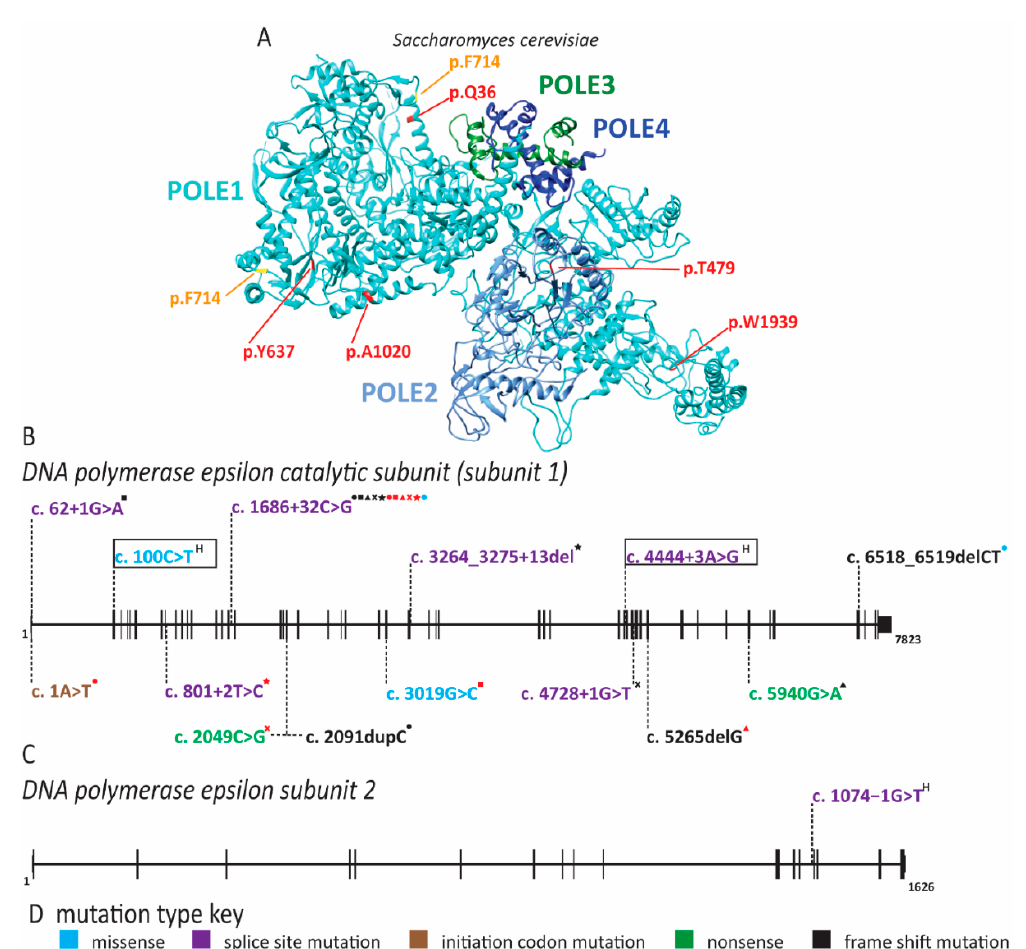
Figure 9. Pathogenic variants in pol ε cause immunodeficiency. Pathogenic mutations in pol ε subunits are depicted on a schematic of each gene and the crystal structure of Saccharomyces cerevisiae proteins. Mutations that do not have corresponding amino acids in the structure or resulted in abnormal splicing are not depicted. For a complete list of mutations and associated protein changes, see Supplementary Table S1. Structures were generated with the Chimera program (http://www.cgl.ucsf.edu/chimera). Exon and intron schematics were generated with the UCSD genome browser. Reference sequences are POLE1 NM_006231.4 and POLE2 NM_001197331.3. ( A ) Alignment of Homo sapiens and Saccharomyces cerevisiae POLE1 and POLE2 was completed using UniProt alignment tool (https://www.uniprot.org/align/). Crystal structure of yeast pol ε subunits with amino acids corresponding to missense (red), nonsense mutations (red) and frame shift mutations (orange) depicted. The structure was generated using pdb file 6wjv. Schematic of ( B ) POLE1 and ( C ) POLE2 genes depicted with exons as black boxes and introns as horizontal lines. Mutations are mapped to the appropriate gene regions. Boxed alleles on POLE1 occur in individuals with FILS syndrome. “H” superscript indicates a homozygous mutation. Compound heterozygous mutation pairs are indicated by superscript symbols. Each mutation combination is depicted, and certain alleles may be present in multiple combinations such as c.1686 + 32C > G which is shared by all individuals with IMAGe syndrome. The frequency of each allele in the affected population is not indicated. ( D ) For each gene, the color of the mutations indicates the type of mutation according to this